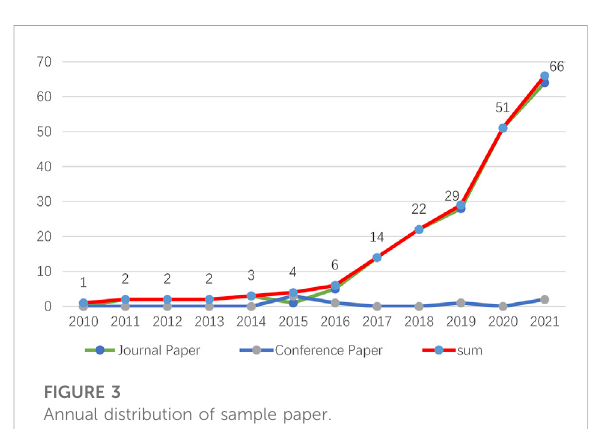
FIGURE 3 Annual distribution of sample